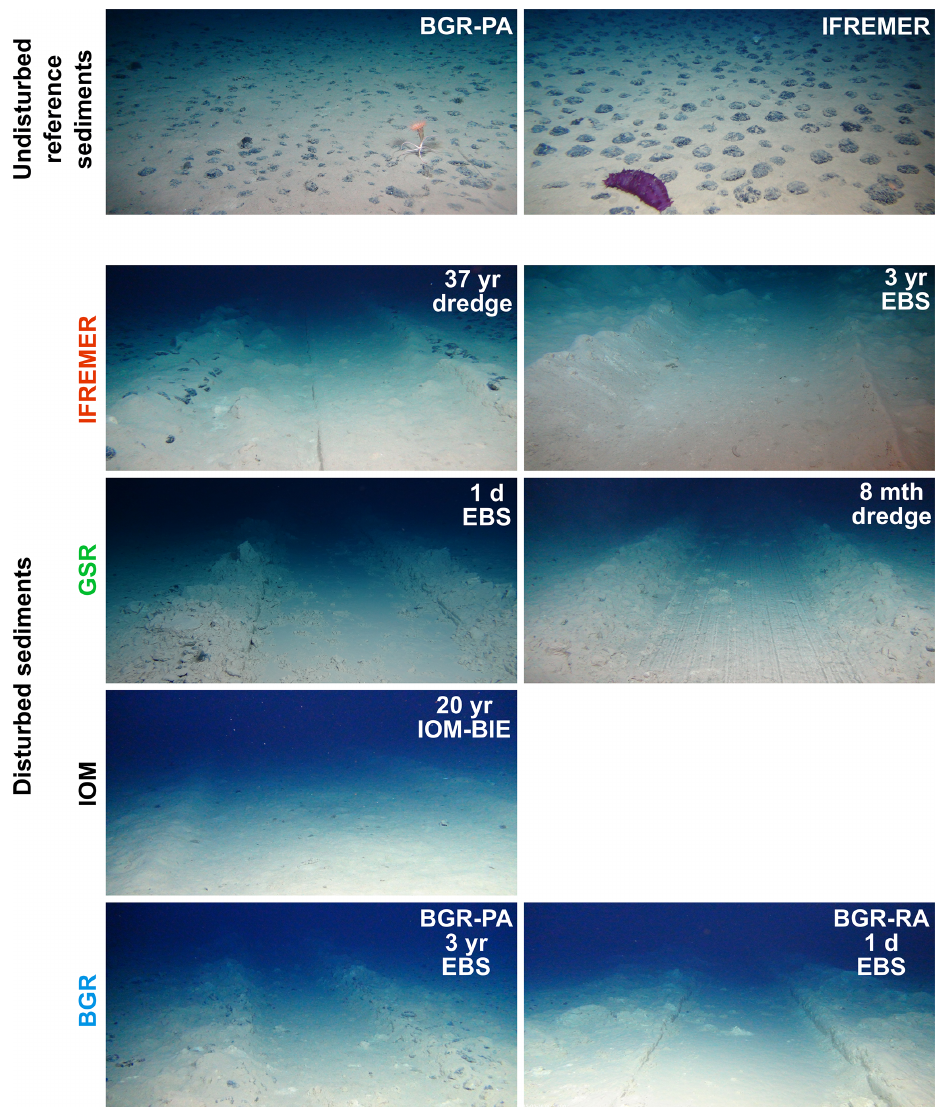
Figure 2. Examples of undisturbed reference sediments in the German BGR-PA area and the French IFREMER area and pictures of small- scale disturbances for the simulation of deep-sea mining within the CCZ, which are investigated in the framework of this study (years: yr; months: mth; days: d). Copyright: ROV KIEL 6000 Team, GEOMAR Helmholtz Centre for Ocean Research Kiel,